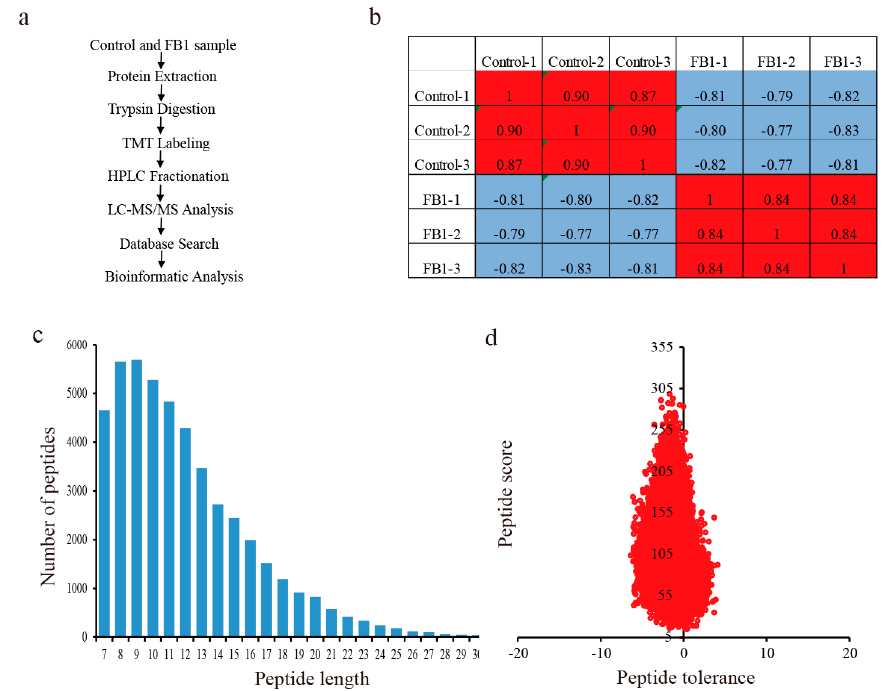
Figure 3. Experimental strategy for the quantitative proteome analysis and the mass spectrometry data for the quality control analysis. ( a ) Experimental strategy for the quantitative proteome analysis. ( b ) Pearson correlation coefficients from all quantified proteins between each pair of samples. ( c ) Length distribution of all identified peptides. ( d ) Peptide mass tolerance distribution.